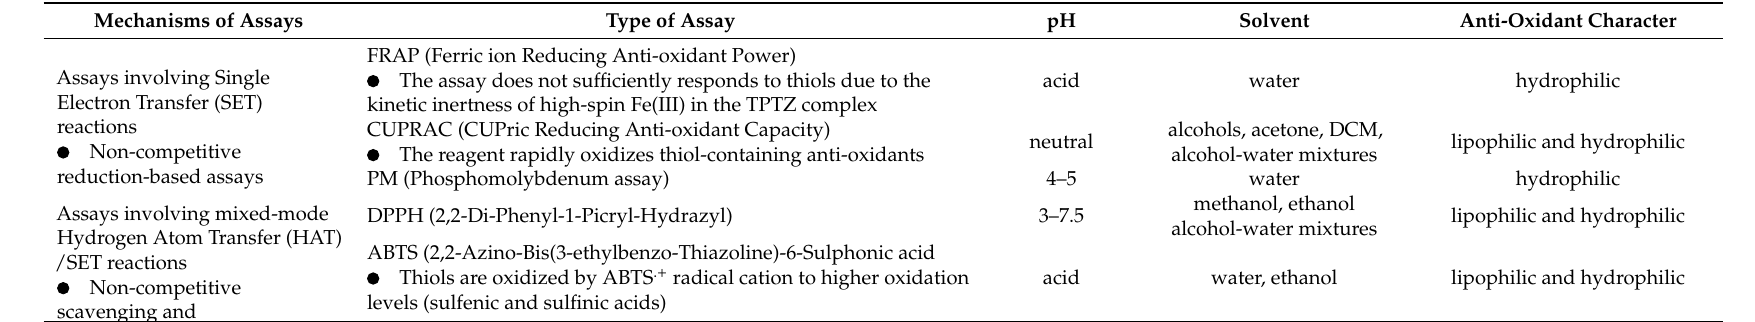
Table 1. In vitro anti-oxidant capacity assays used for assessing the total anti-oxidant capacity (TAC) of compounds 1 – 9